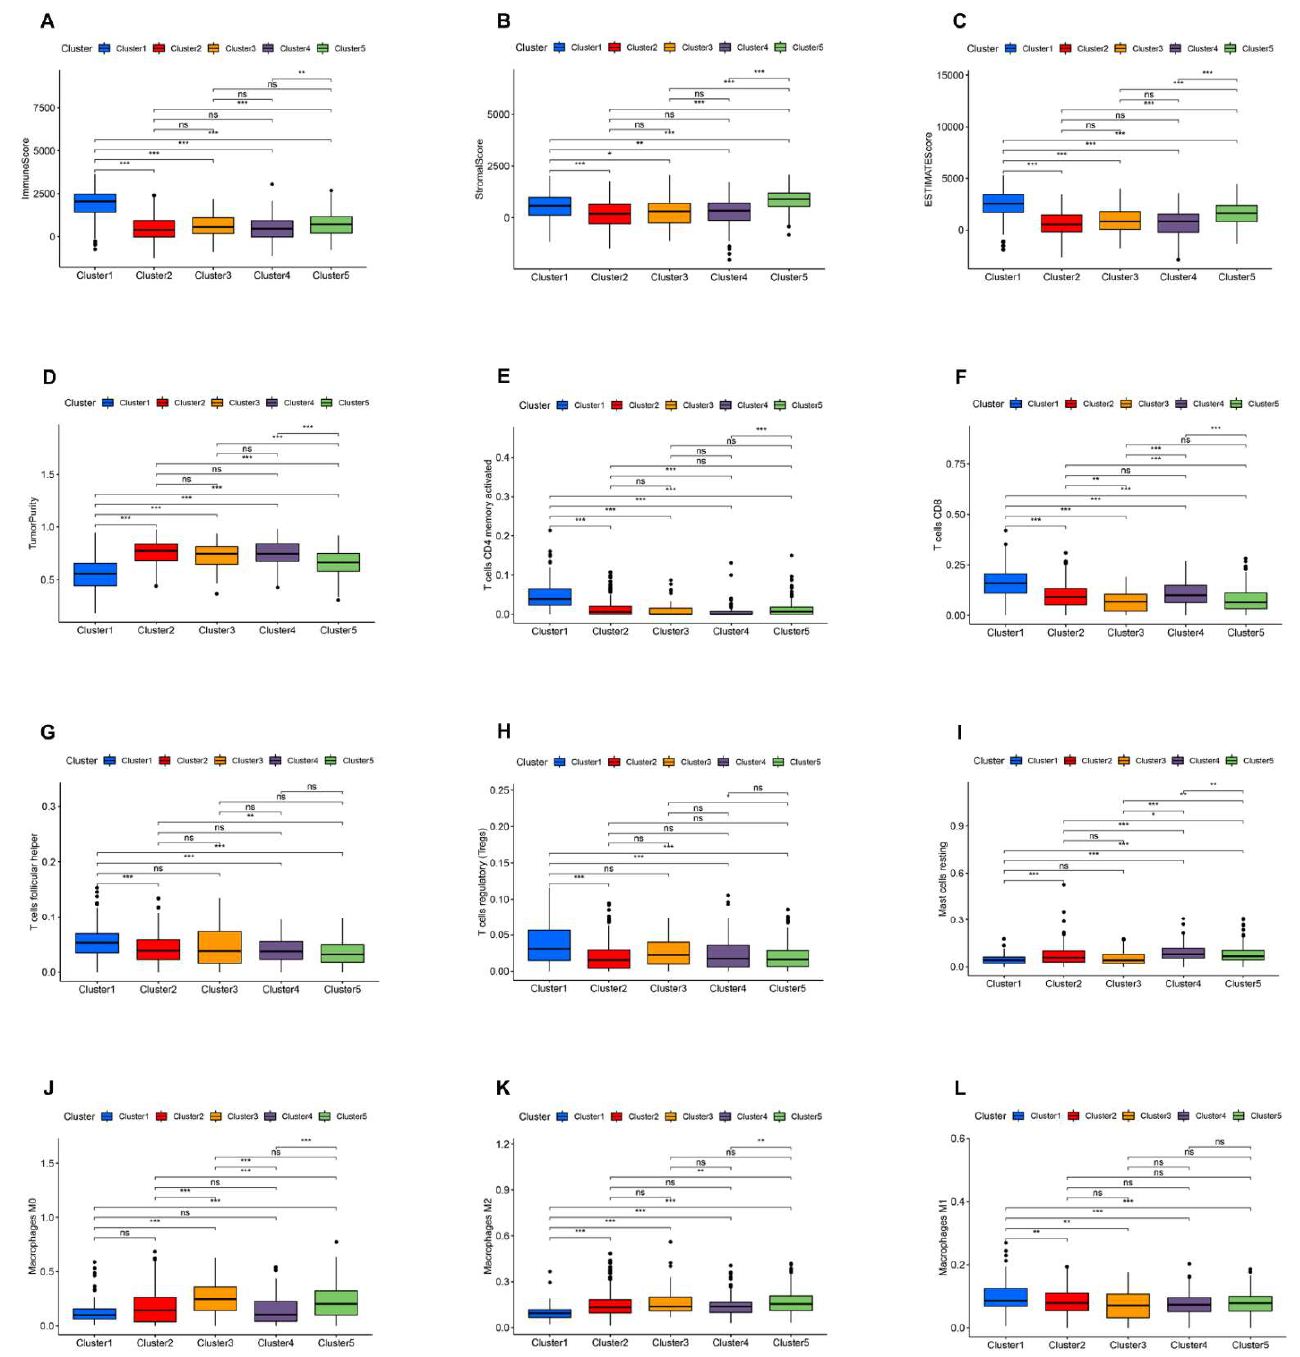
Figure 3. Immune signatures of five AR-lncRNA BC clusters. ( A – D ) Different expression of immune score ( A ), immune score ( B ), stromal score ( C ), ESTIMATE score, and Tumor Purity ( D ) in five BC clusters. ( E – L ) Differences in the levels of infiltration of CD4 memory T cells, CD8 T cells, follicular helper T cells, regulatory T cells, resting mast cells, M0 macrophages, M2 macrophages, and M1 macrophages in five BC clusters. ns, no significance; * p < 0.05, ** p < 0.01, and *** p < 0.001.